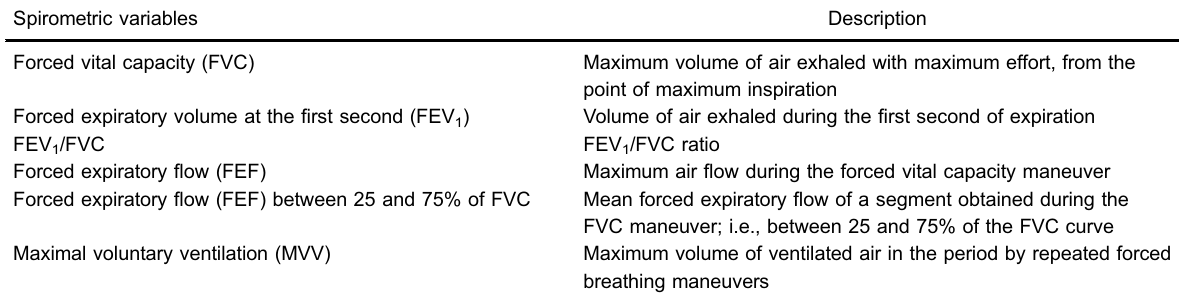
Table 1. Spirometric